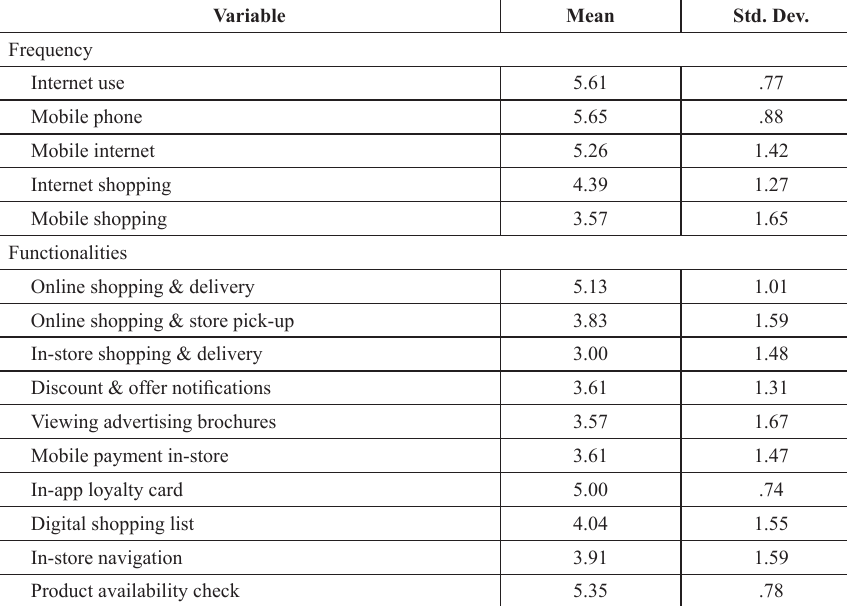
Table 1. Descriptive data of cluster 1 (N = 23)